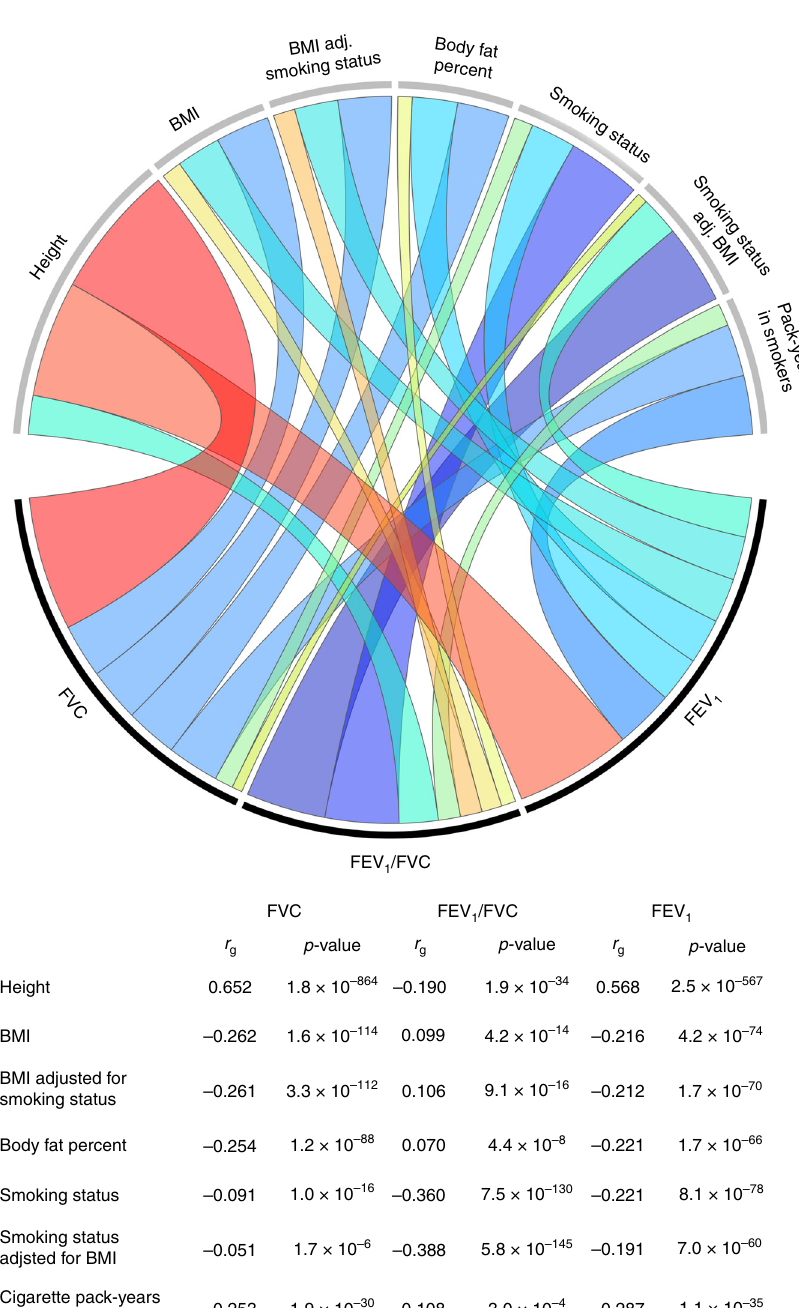
Fig. 2 Genetic correlation ( r g ) between pulmonary function phenotypes and anthropometric and smoking phenotypes. Estimates for r g are based on UK Biobank-speci fi c LD scores. The colors in the Circos plot correspond to the direction of genetic correlation, with warm shades denoting positive relationships and cool tones depicting negative correlations. The width of each band in the Circos plot is proportional to the magnitude of the absolute value of the r g